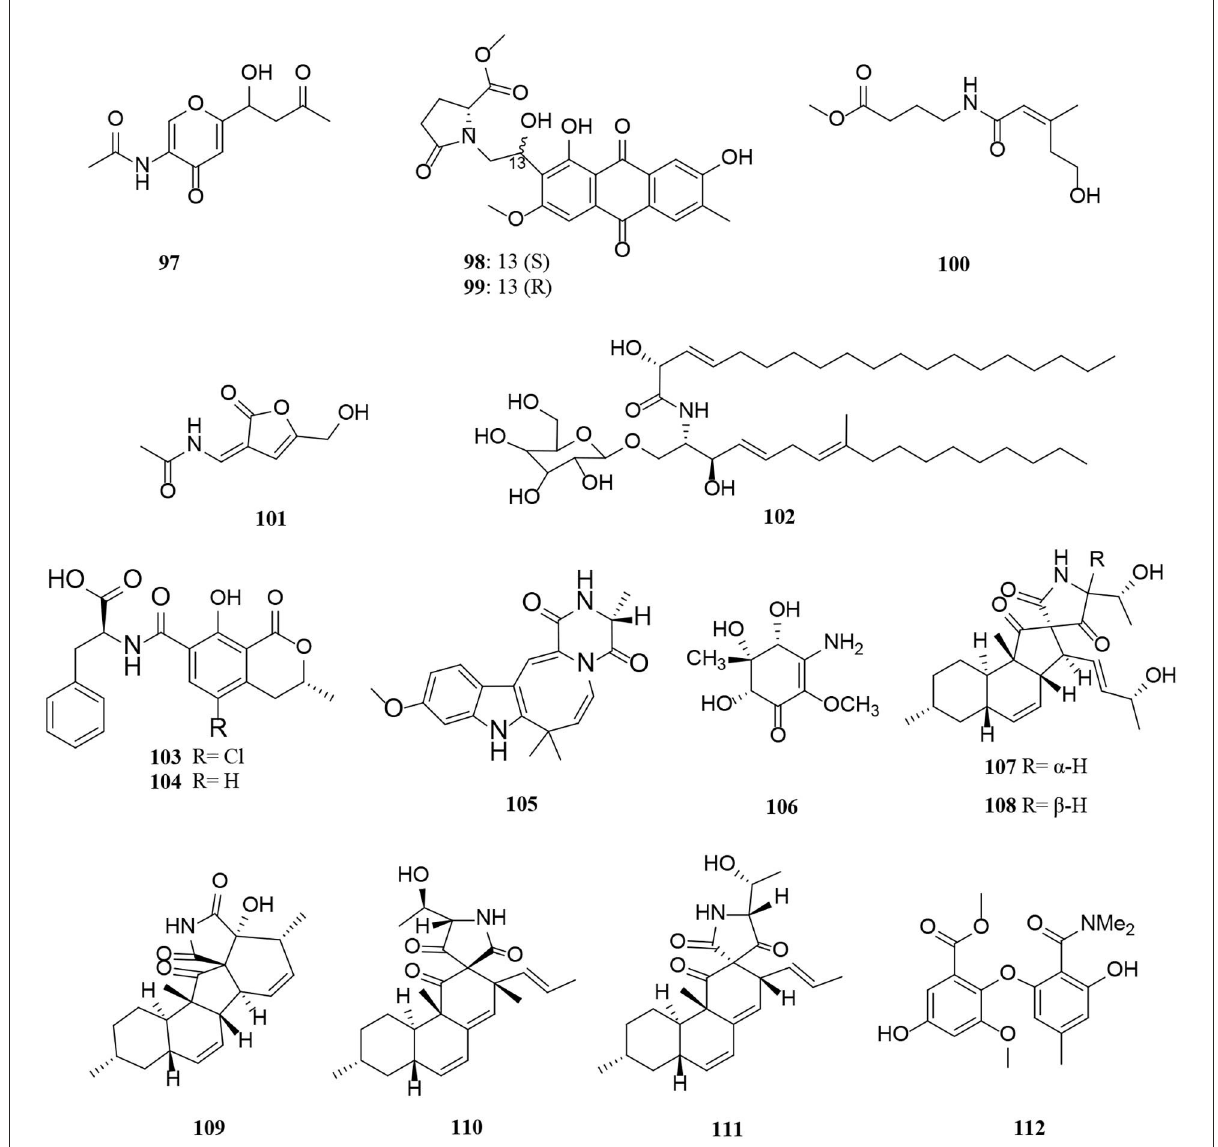
FIGURE6 Amide derivatives ( 97 – 112 ) from Alternaria fungi.